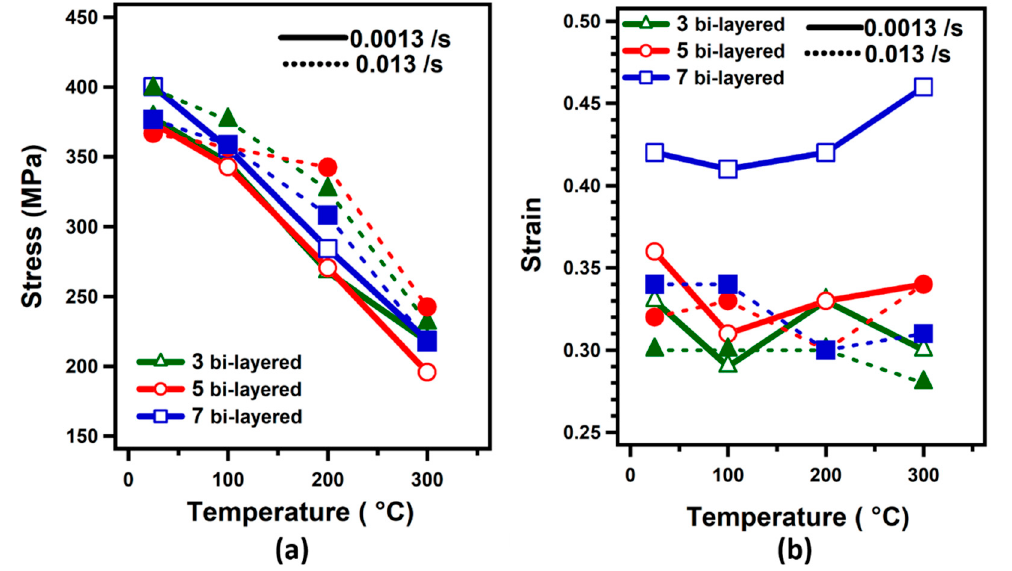
Figure10. ( a )Stress-temperatureand( b )strain-temperaturecurvesforTi-Allaminatedmetalcomposites Figure 10. ( a ) Stress-temperature and ( b ) strain-temperature curves for Ti-Al laminated metal obtained from bulge tests at di ff erent strain composites obtained from bulge tests at different strain rates.